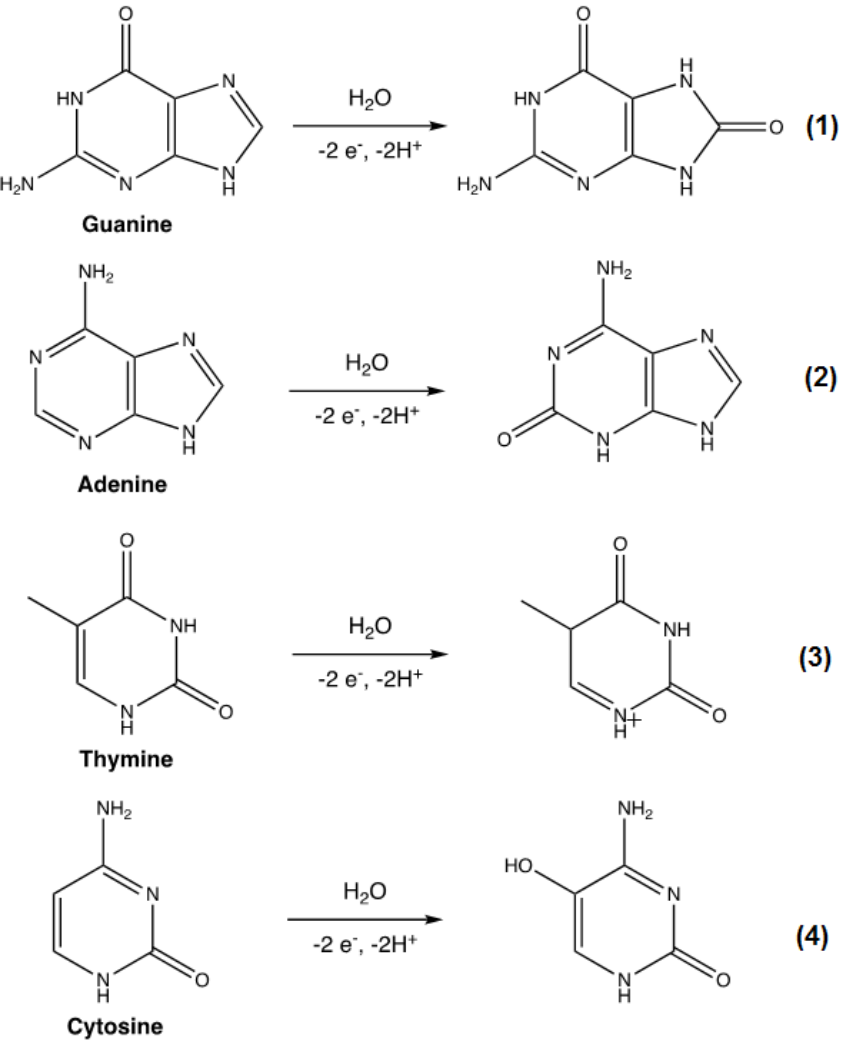
Scheme 2. The electrochemical oxidation of